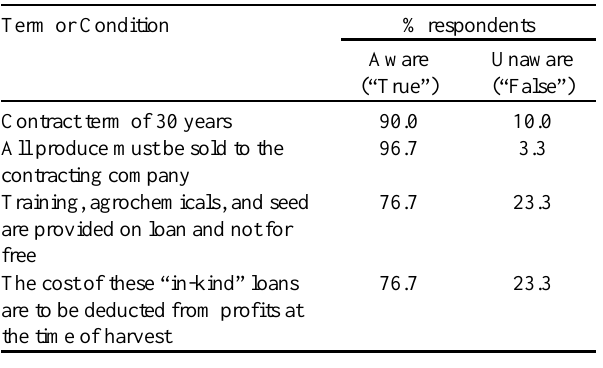
Table 1 . Awareness among farmers of the terms of Marli outgrower contracts in Chinsali District (n = 30).